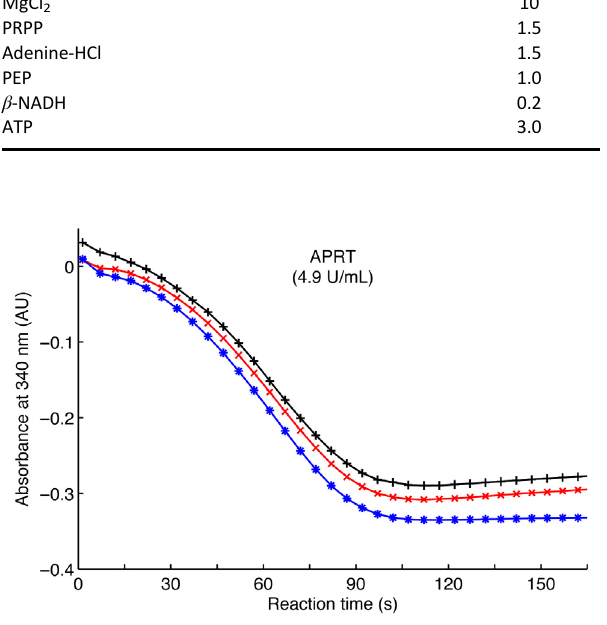
Figure 9. Enzymatic activity assay of APRT. The activity was calculated using the maximum linear rate observed in each trace (Equation 1) and reported as the average of triplicate measure- ments. A typical activity is shown.